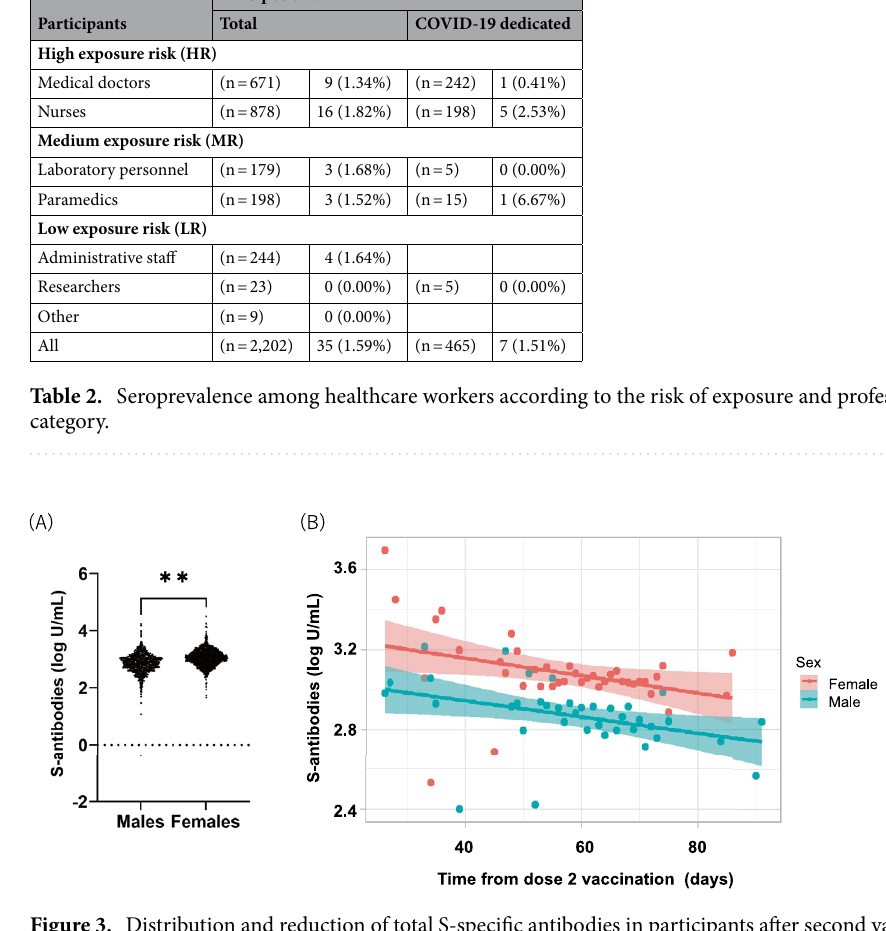
Figure 3. Distribution and reduction of total S-specific antibodies in participants after second vaccination by sex. ( A ) Total S-specific antibody levels were quantified. Statistical analysis was performed with student t testing between males (n = 741) and females (n = 1461). **p value < 0.001. ( B ) Scatterplot and regression line colors indicate antibody response for males and females. The 95% CIs are calculated by prediction ± 1.96 × standard error of